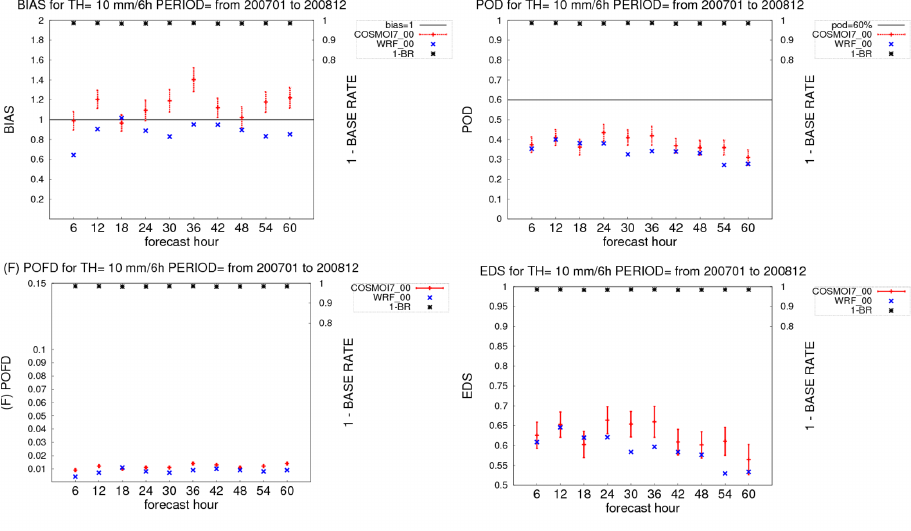
Fig. 11. Diurnal cycle: BIAS, POD, POFD and EDS for 10mm6h − 1 threshold. The dashed red lines and the blue daggers represent COSMO-I7 and WRF respectively. The Base Rate (stars) is plotted for each